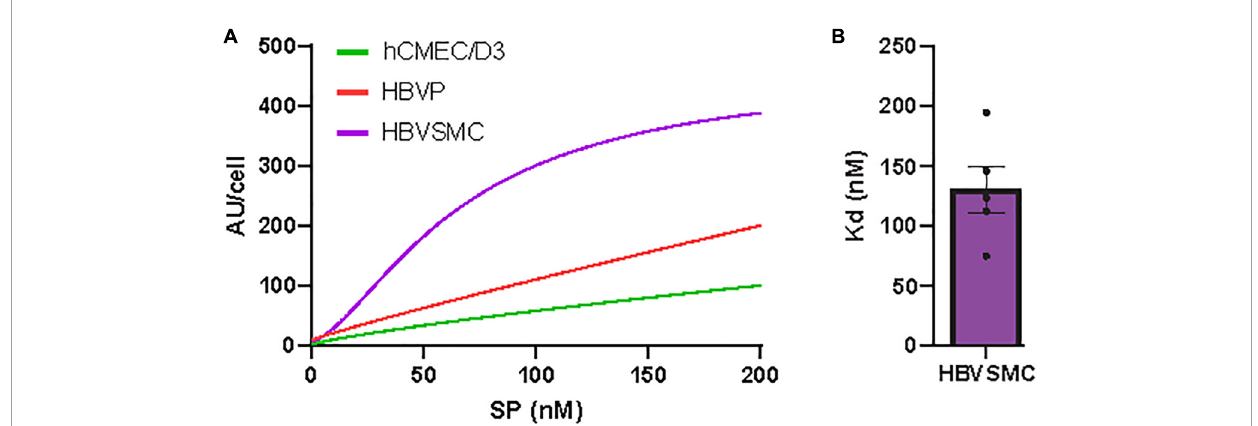
FIGURE2 Concentration-dependent SARS-CoV-2/SP uptake by cerebrovascular cells. (A) SP-555 uptake at different SP-555 concentration for the hCMEC/D3 (green), HBVP (red), and HBVSMC (purple) using curve fitting. (B) Binding constant (Kd) for HBVSMC that was best fitted to a saturable uptake. There was no saturation for the other cell types over the concentrations used. Values are mean ± SEM. N = 3–5 wells/group Au = Fluorescence arbitrary unit. Supplementary Figures 1 , 2